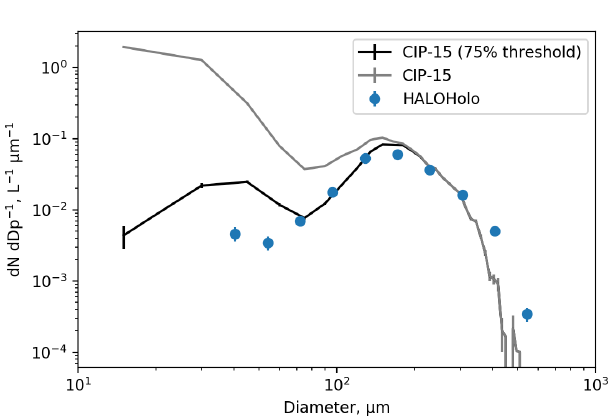
Figure 12. Size distributions from the CIP-15 and HALOHolo for a run at − 42 ◦ C on 7 February 2018. The black line shows the CIP-15 size distribution when images are filtered to only include those with at least one pixel at the 75% intensity